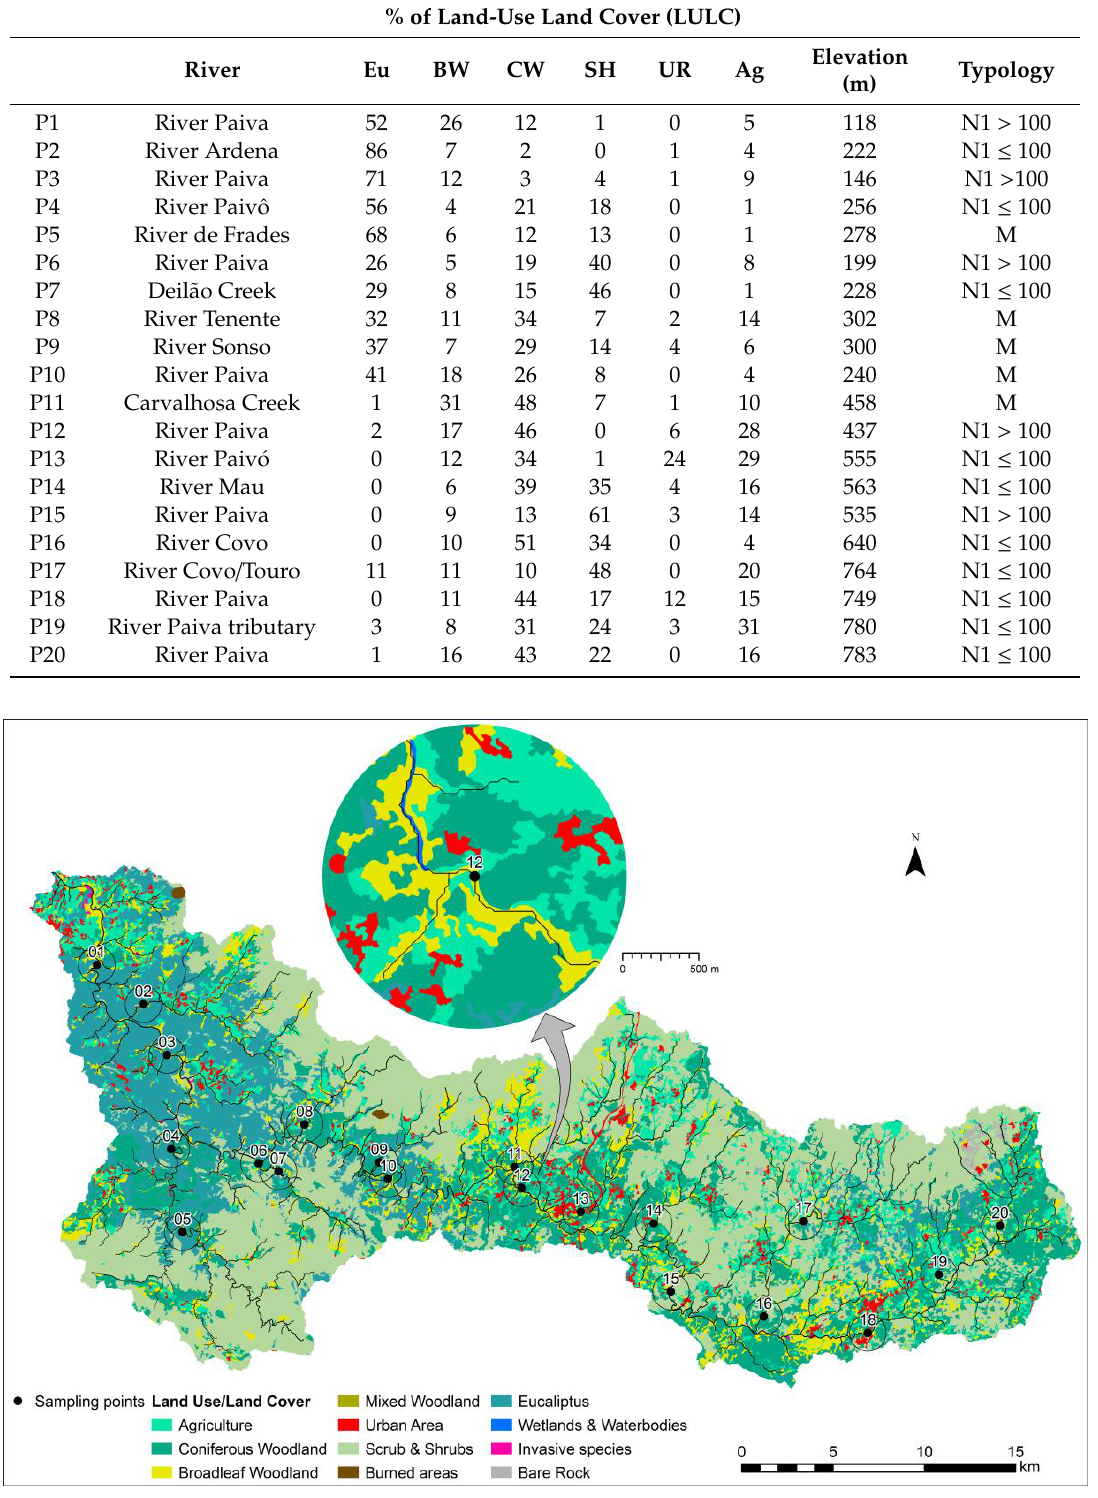
ff ers in their